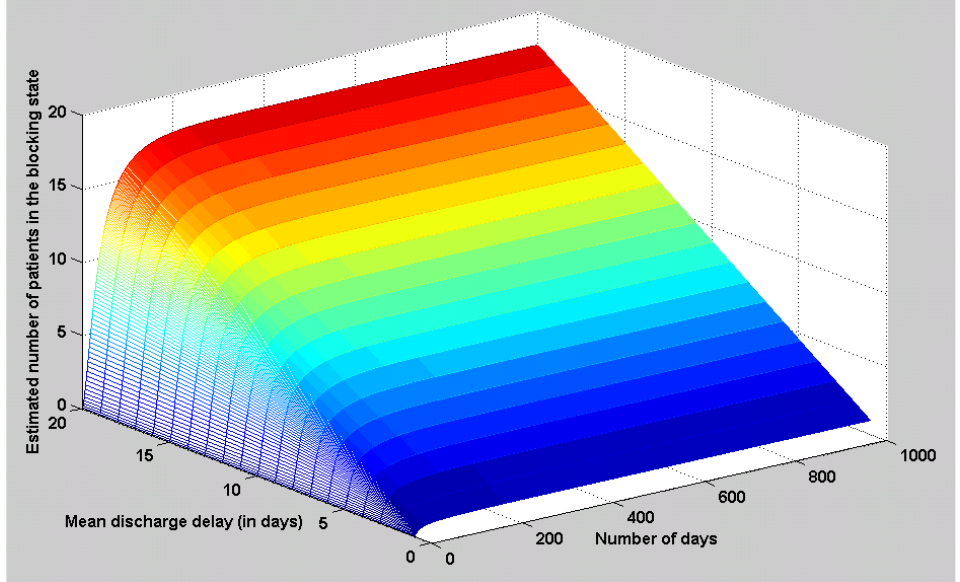
Figure 5. The estimated total number of patients (with respect to the mean discharge delay and the number of days) in the blocking state.